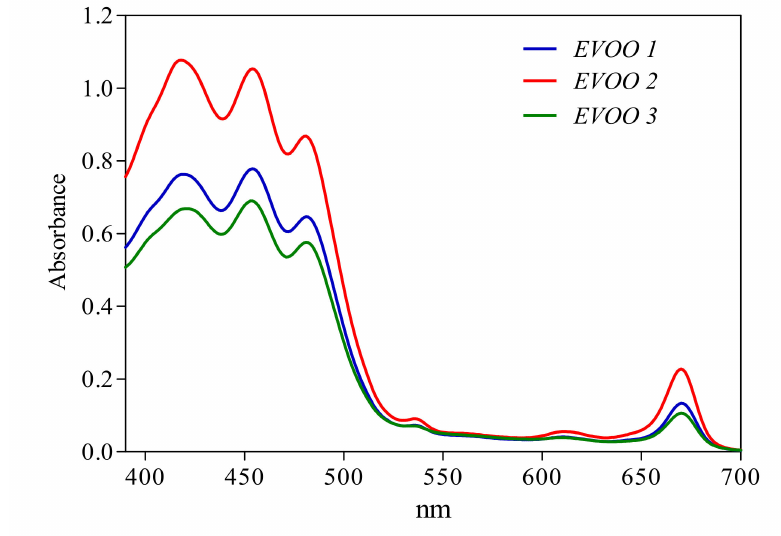
Figure 3. Near-UV-Vis absorption spectra of the three EVOO samples (EVOO 1: blue, EVOO 2: red and EVOO 3: green) in the range of wavelengths from 390 to 700